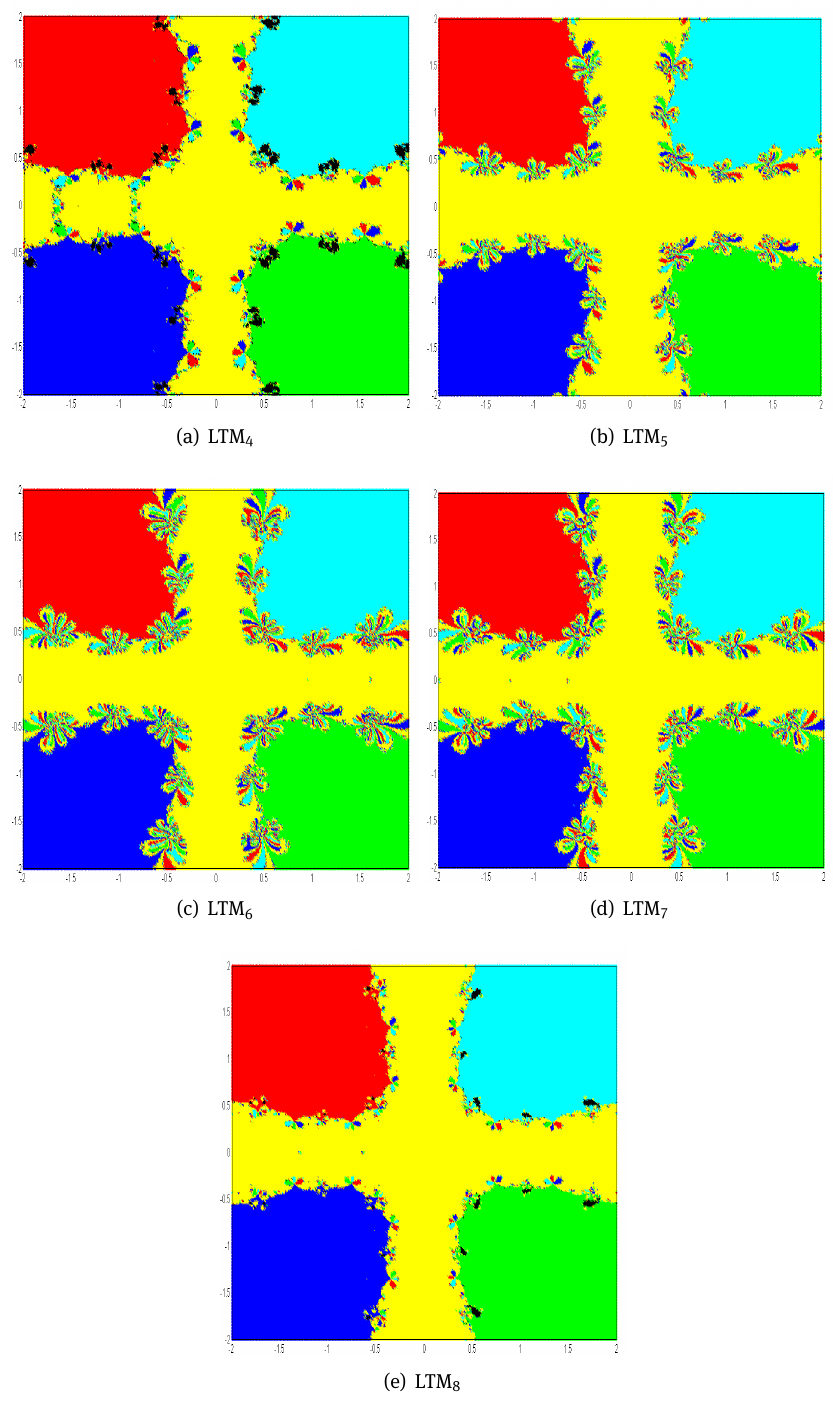
Figure 6: Basins of attraction of the methods LTM 4 , LTM 5 , LTM 6 , LTM 7 and LTM 8 respectively for P 2 ( z ) = z 5 + z